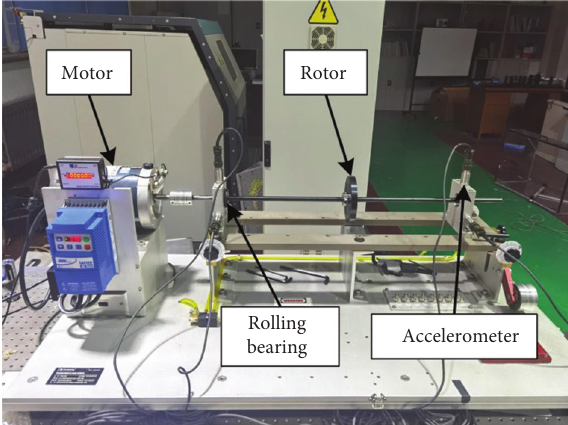
Figure 7: The machinery fault simulator.